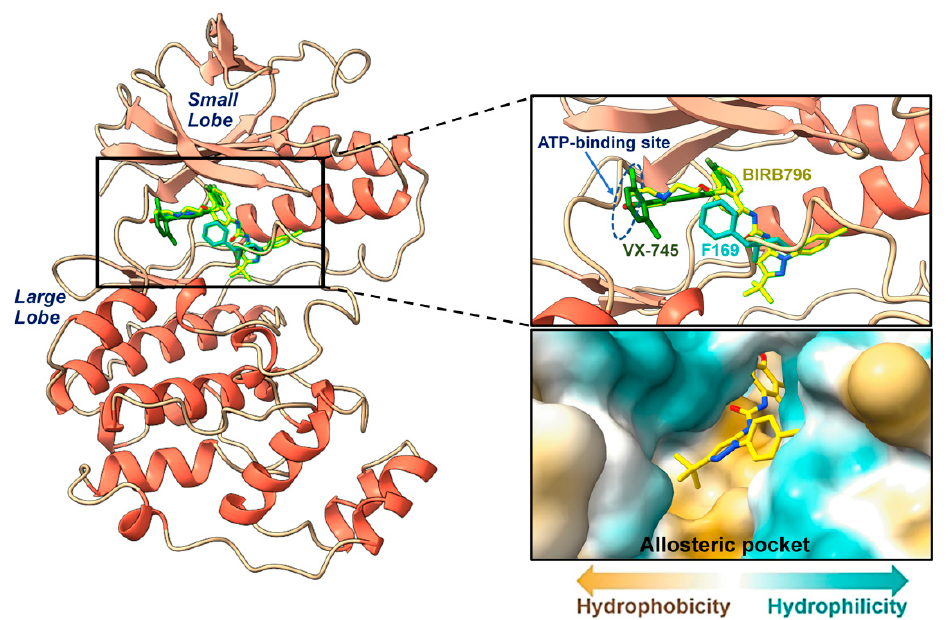
Figure 1. The ribbon representation of the 3D structure of p38 α MAPK (PDB ID: 1KV2). The close-up regions illustrate two common inhibitors including VX-745 (green) and BIBR796 (yellow), indicating the ATP-binding site and allosteric pocket, which is distinct from each other at about 60 ◦ spatially. An orientation of F169 exhibiting the unique DFG-out conformation is also shown. Additionally, the hydrophobic nature (obtained via UCSF ChimeraX 1.4, Resource for Biocomputing, Visualization, and Informatics (RBVI), San Francisco, CA, USA.) within the focused allosteric cleft is depicted in a close-up view.